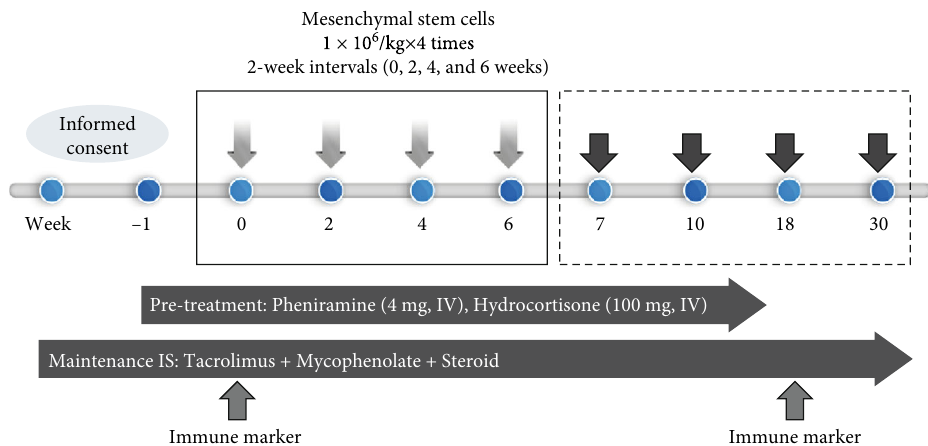
Figure 1: Clinical protocol for mesenchymal stem cell treatment of kidney transplant recipients with chronic active antibody-mediated